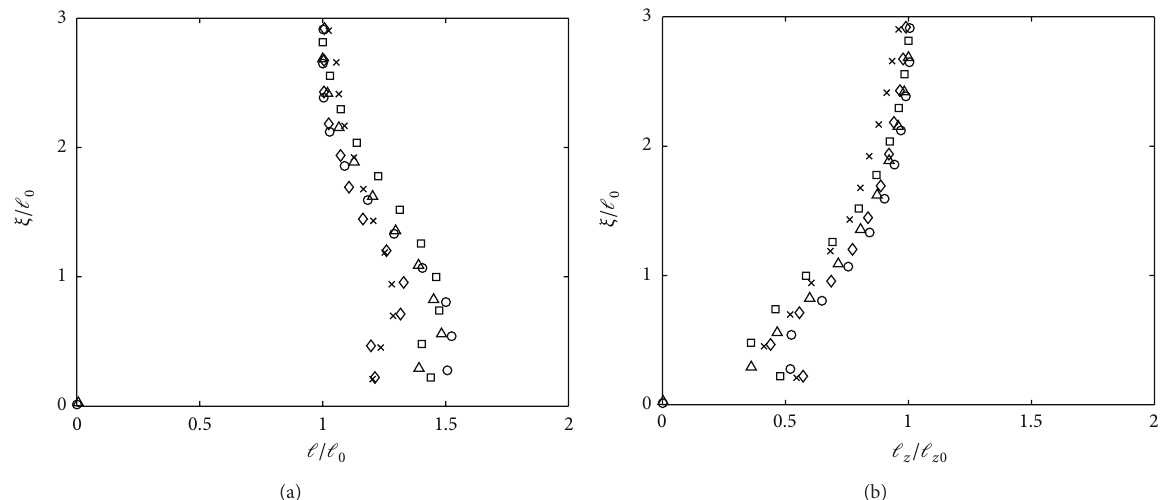
Figure 5: Plots showing measurements of integral length scales at near base for (a) horizontal ℓ and (b) vertical ℓ 𝑧 against dimensionless distance above the tank base 𝜉/ℓ 0 . Refer to Figure 3 for legends of plots in (a) and (b), respectively.